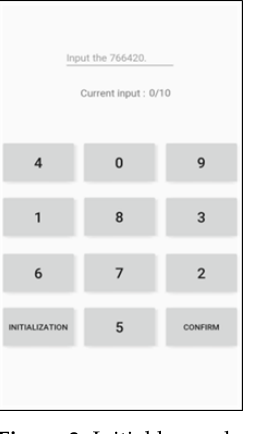
Figure 3. Initial keypad.